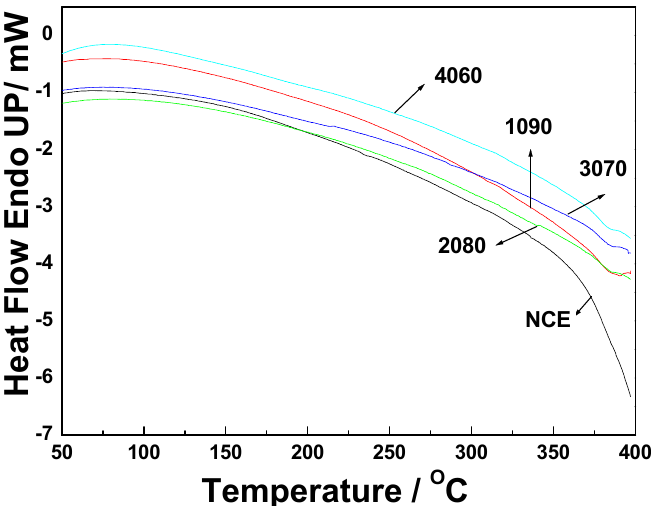
Figure 11. DSC scanning of NCE, 1090, 2080, 3070, and 4060 polymers under nitrogenous atmosphere.